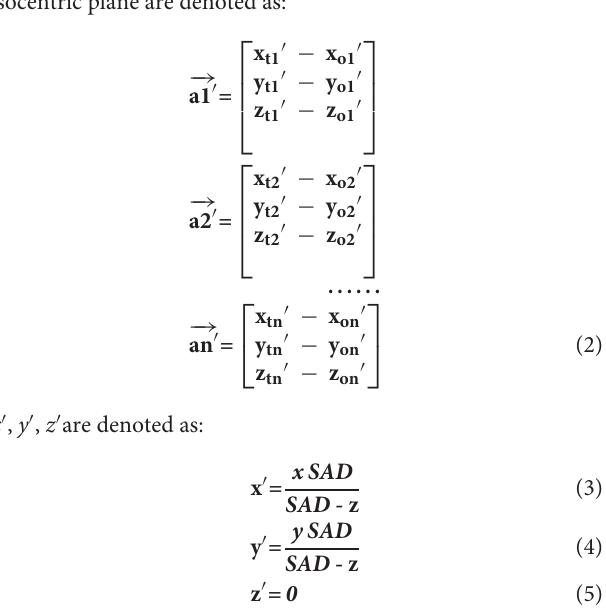
−→ −→ −→ a 1, a 2, ...... an onto